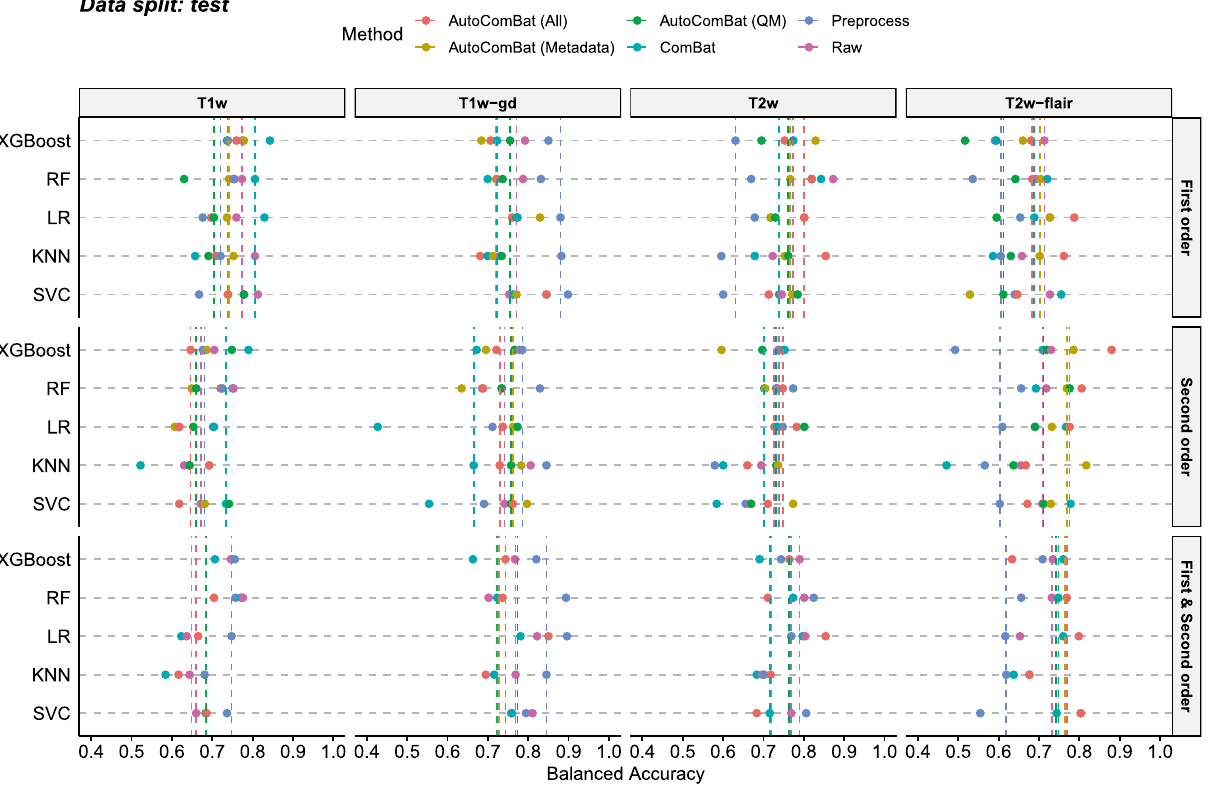
Figure 7. Balanced accuracy for the tumor grading task for the 5 machine learning models (RF, SVC, XGBoost, KNN, LR) and the different MRI images (T1w, T1w-gd, T2w, T2w-flair) on the test set for the first, second and first & second-order feature types depending on the harmonization method. Each color corresponds to a harmonization method. Each dot indicates the performance of one ML algorithm, and the vertical dashed line is the median value of the performance of the 5 ML